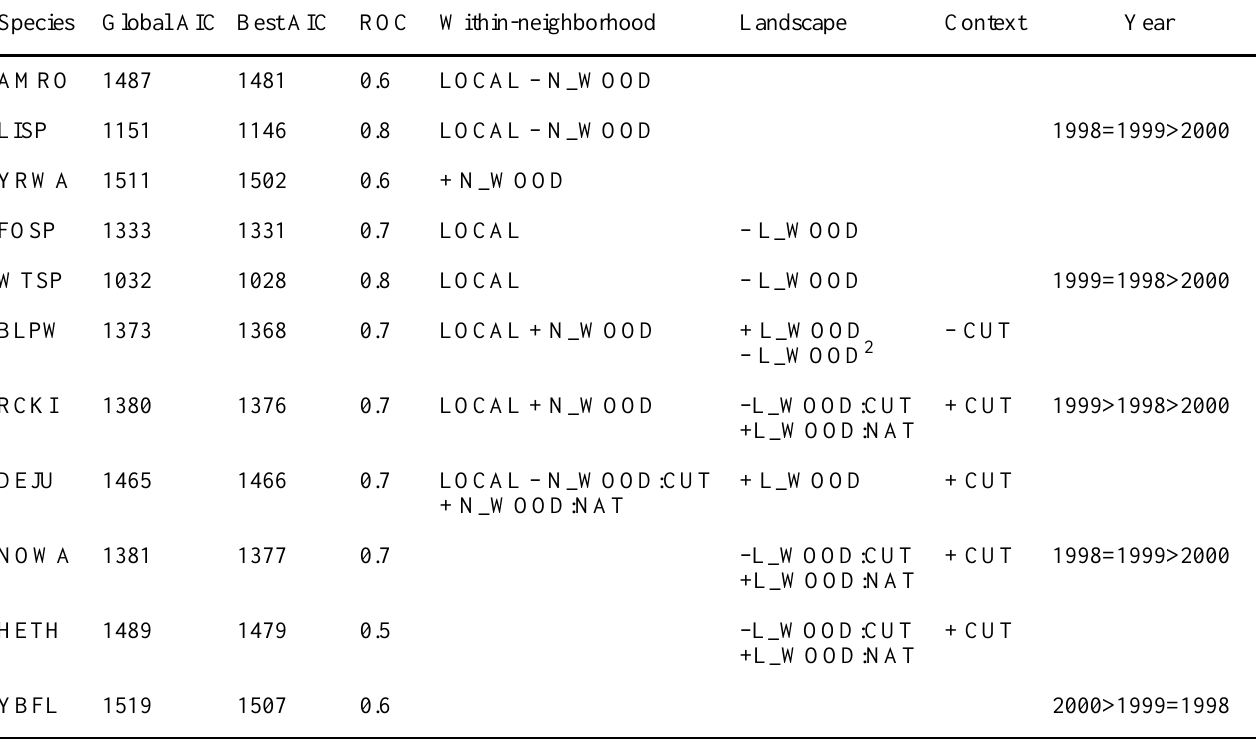
Table 2. Summary of model outcomes illustrating the general relationship between occurrence and significant explanatory variables. Parameter estimates and standard errors are presented in Table 3. :, interaction; 2 , quadratic; CUT, harvested context; NAT, natural